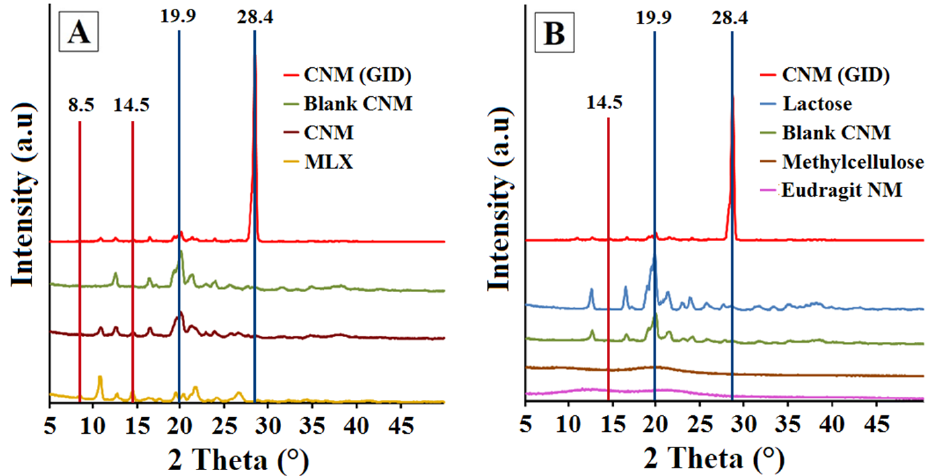
Figure 8. ( A ) Comparison between powder X-ray diffraction (XRD) and grazing X-ray diffraction (GID) patterns of CNM (GID); CNM (XRPD); blank CNM (XRPD) and pure MLX (XRPD). ( B ) Comparison between powder X-ray diffraction (XRD) and grazing X-ray diffraction (GID) patterns of CNM (GID); Lactose (XRPD); blank CNM (XRPD); Metolose ® (XRPD) and Eudragit ® NM (XRPD).